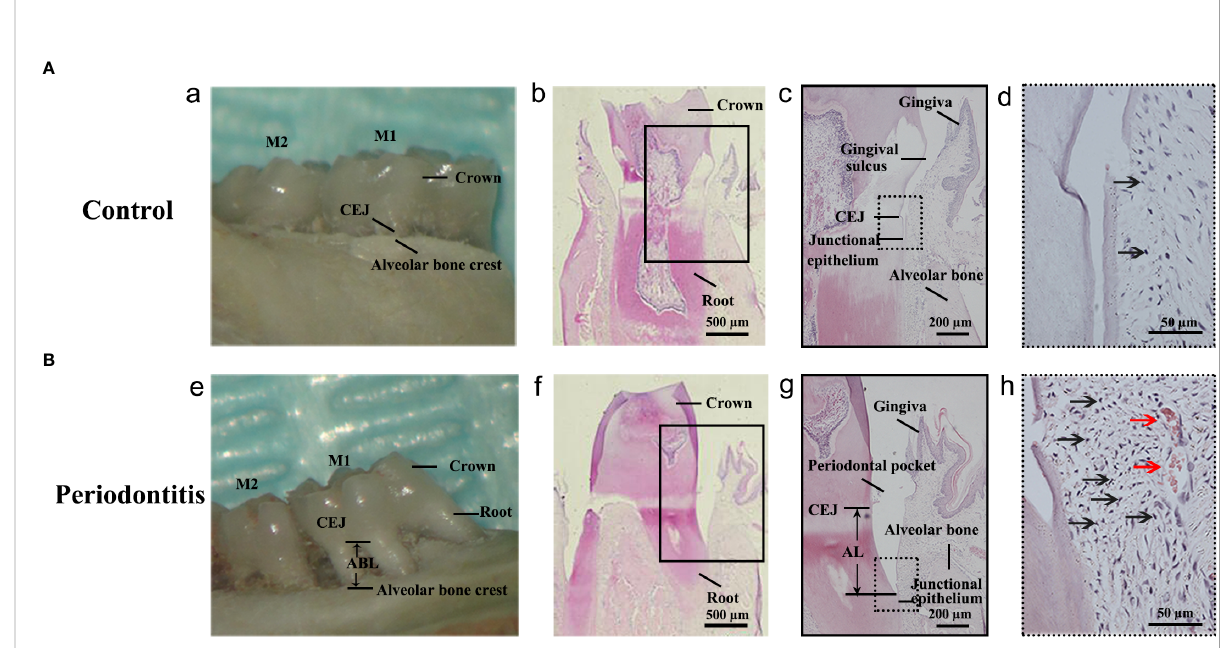
FIGURE 2 Establishment of the experimental periodontitis model in rats. (A, B) The fi gures presented the gross specimens and sections obtained individually from the control group and the periodontitis group. (a, e): As shown in the gross specimen, the distance from the cemento-enamel junction (CEJ) to the alveolar bone crest in the periodontitis group was remarkably longer than that in the control group, that is alveolar bone resorption occurred. (b, c): As shown in the section from the control group with hematoxylin and eosin (HE) staining, the junctional epithelium is located at the CEJ site. (f, g): The section from the periodontitis group shows that the junctional epithelium was located on the root, that is attachment loss (AL) occurred. (d, h): Compared with that from the control group, more in fl ammatory cells and more severe vasodilatation was observed in the gingival tissue from the periodontitis group. The black arrows in (d, h) indicates the in fl ammatory cell (especially neutrophile) in fi ltration. The red arrows in (h) indicates vasodilatation. M1, the maxillary fi rst molar; M2, the maxillary second